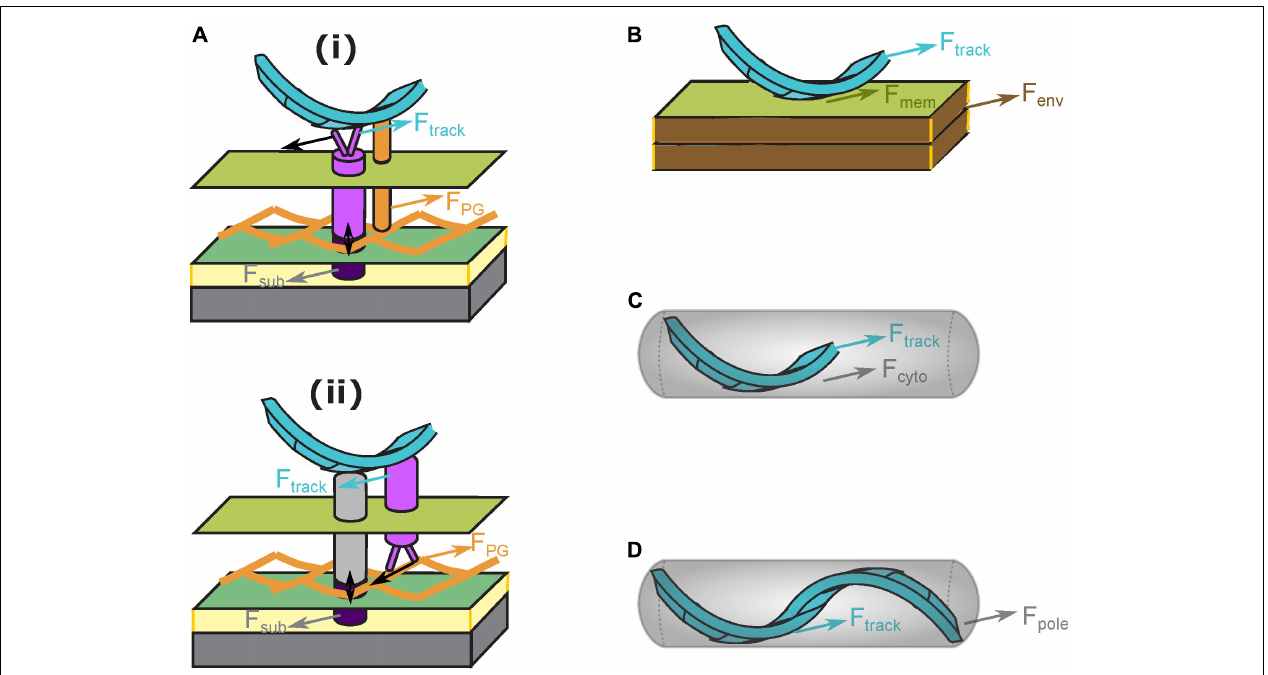
FIGURE 3 | Hypotheses about transmission of motor force to the cell body. (A) Mechanical tethering between the intracellular track and cell envelop. The mechanical tethering can be mediated either through non-motor components of the gliding machinery (i) or directly through the motor components (ii) . In case (ii) , the “feet” of the motor are on the periplasmic side because the motor must travel with respect to the PG to stay static to the substrate. Bright purple: proton channel motor. Dark purple: outer subcomplex. Orange cylinder in case (i) mechanical tethering between the intracellular track and PG. Gray cylinder in case (ii) molecules connecting the intracellular track to the outer subcomplex (through dynamic binding/unbinding to avoid tearing the PG). Black arrows illustrate the moving direction of the motor. (B) Interaction between the intracellular track and cell membrane/envelop. (C) Viscous drag between the intracellular track and cytoplasm. (D) Direct push on the cell pole by the intracellular